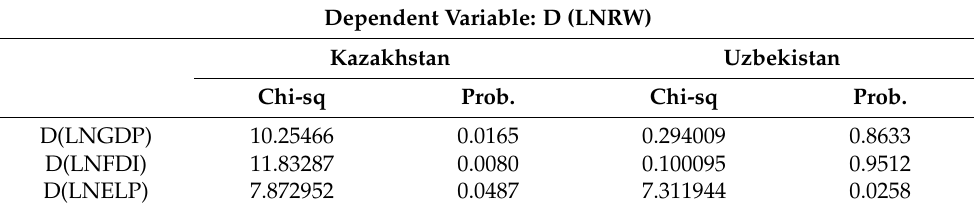
Table 10. VEC Granger causality/block exogeneity Wald